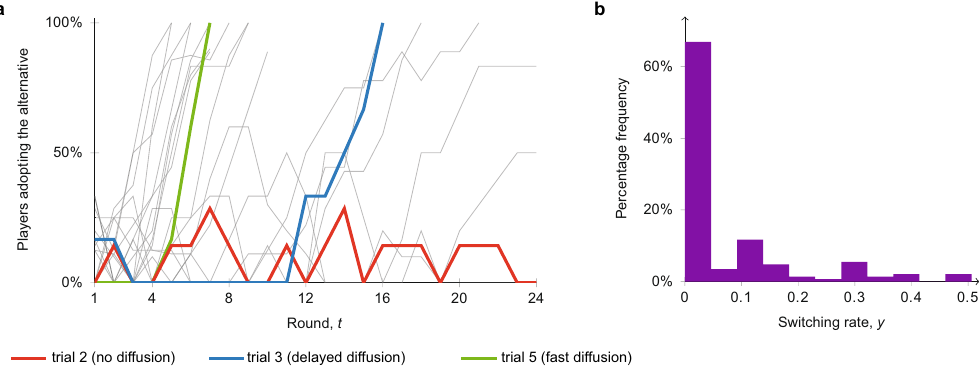
Fig. 1 Population-level and individual-level experimental results. a Temporal evolution of the fraction of participants adopting the alternative in all the 20 trials starting from Stage I. Three trials are highlighted; with committed minority bots making up 25% of the group, the trials illustrate fast diffusion (green), delayed diffusion (blue), and no diffusion (red), respectively. b Distribution of the empirical switching rates of the participants (the fraction of rounds a participant switched strategy during the trial). Notice the highly heterogeneous distribution, with a large peak close to 0 (containing around 67% of all players), and the remainder widely distributed. In the sequel, we show that this type of distribution arises in ABMs when agents are impacted by both inertia and